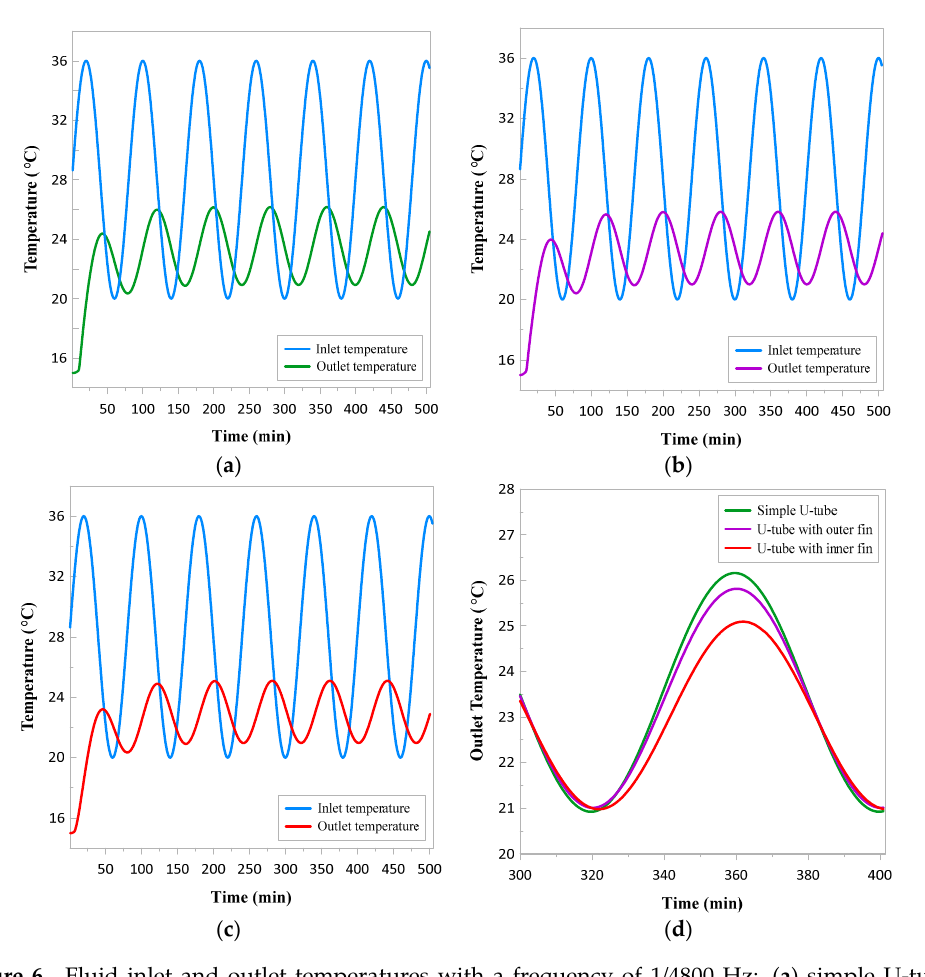
Figure 6. Fluid inlet and outlet temperatures with a frequency of 1/4800 Hz: ( a ) simple U-tube; ( b ) U-tube with outer fins; ( c ) U-tube with inner fins; ( d ) comparison of fluid outlet temperatures in three simple and finned U-tubes.